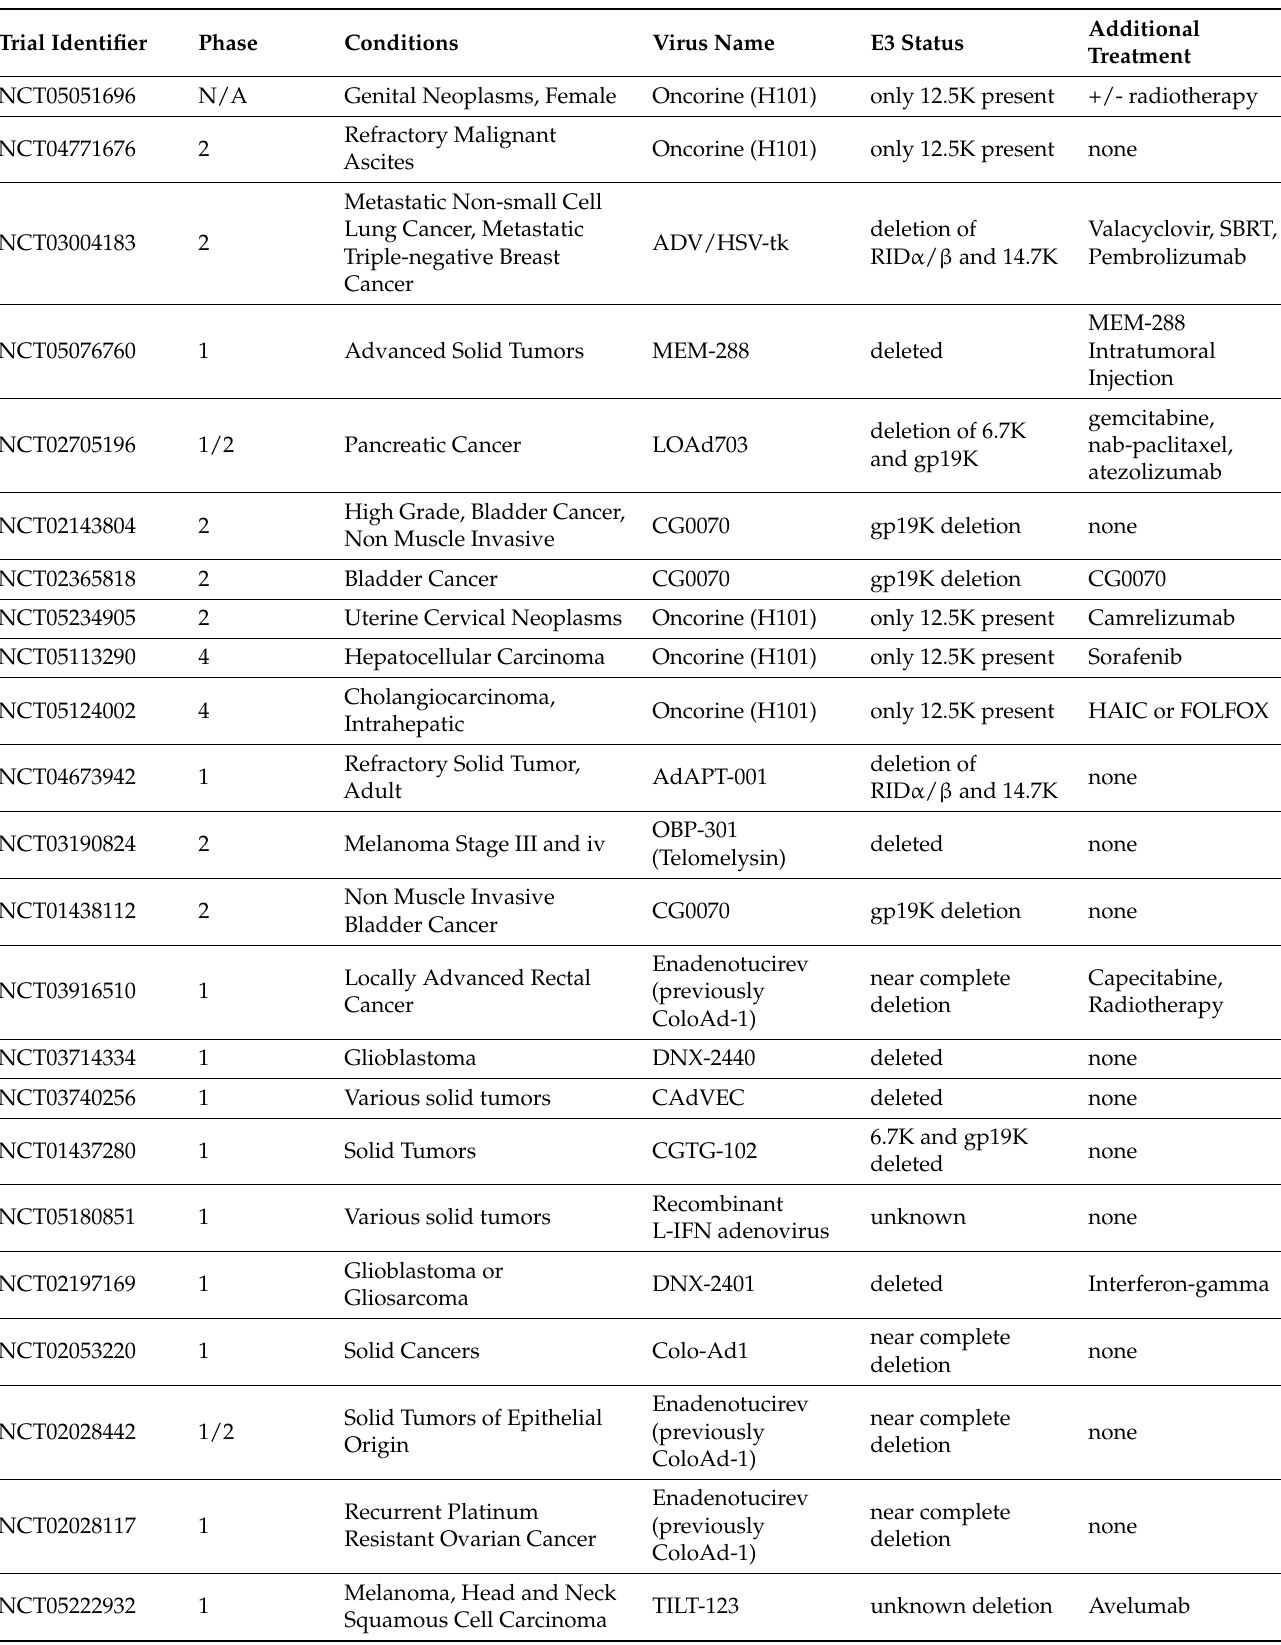
Table 2. List of clinical trials currently using oncolytic Adenoviral vectors as oncolytic agents. (Data source: clinicaltrials.gov, accessed on October